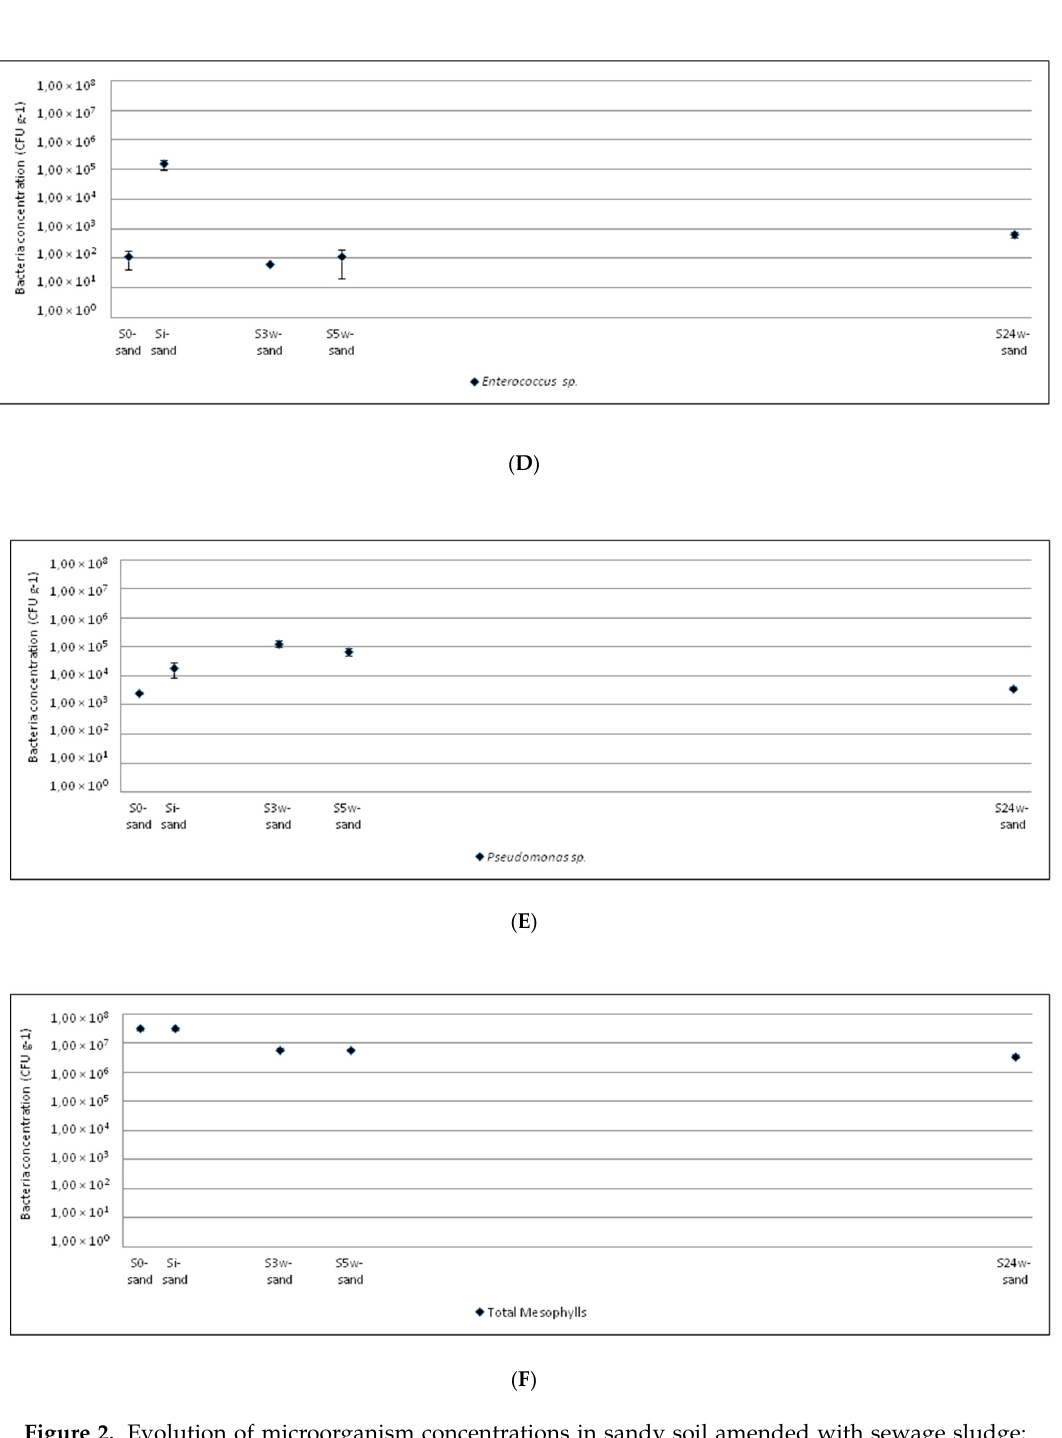
Figure 2. Evolution of microorganism concentrations in sandy soil amended with sewage sludge: ( A ) total coliforms; ( B ) Escherichia coli ; ( C ) Staphylococcus aureus ; ( D ) Enterococcus sp.; ( E ) Pseudomonas sp. ; ( F ) total mesophylls.